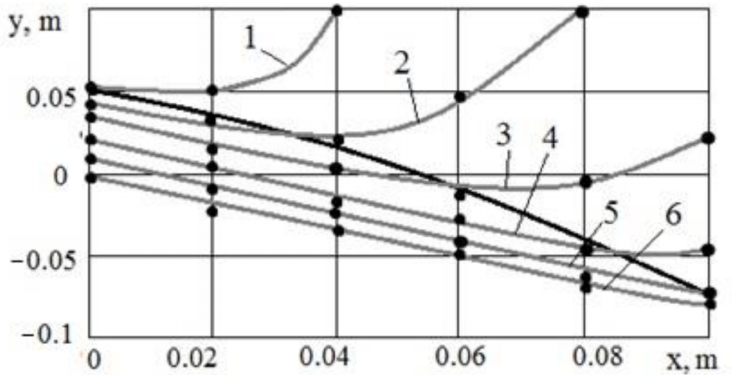
Figure 8. The trajectories of the grain mixture particles in the vertical duct at the initial coordinate: 1—y 0 = 0.05 m; 2—y 0 = 0.04 m; 3—y 0 = 0.03 m; 4—y 0 = 0.02 m; 5—y 0 = 0.01 m; 6—y 0 = 0 m; (H = 0.05 m; i = 7 m · s − 1 ; d p = 0.002 m; ρ p = 700 kg · m − 3 ); —the upper boundary of the grain layer; —trajectories of